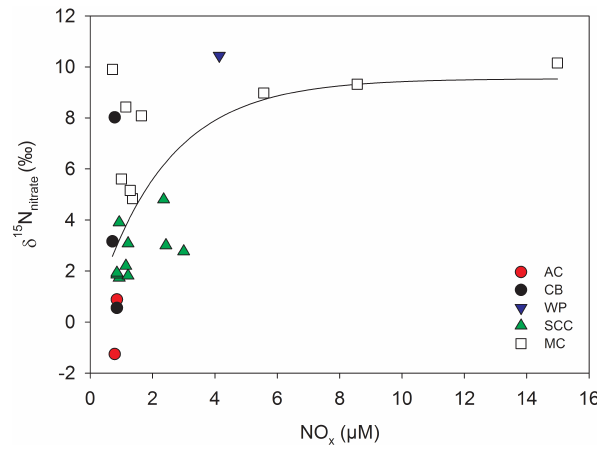
Figure 3. Relationship between nitrate δ 15 N (‰) and the concen- (µM) at each site. 4